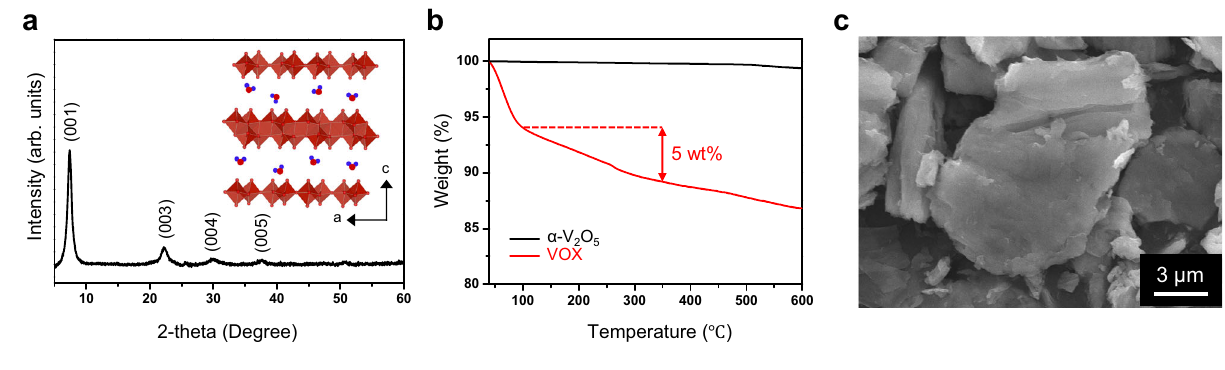
Fig. 1 Characterization of as-prepared VOX. a XRD pattern of VOX. The inset is the crystal structure of VOX viewed along the b-axis. b TGA results of VOX and α -V 2 O 5. c SEM image of